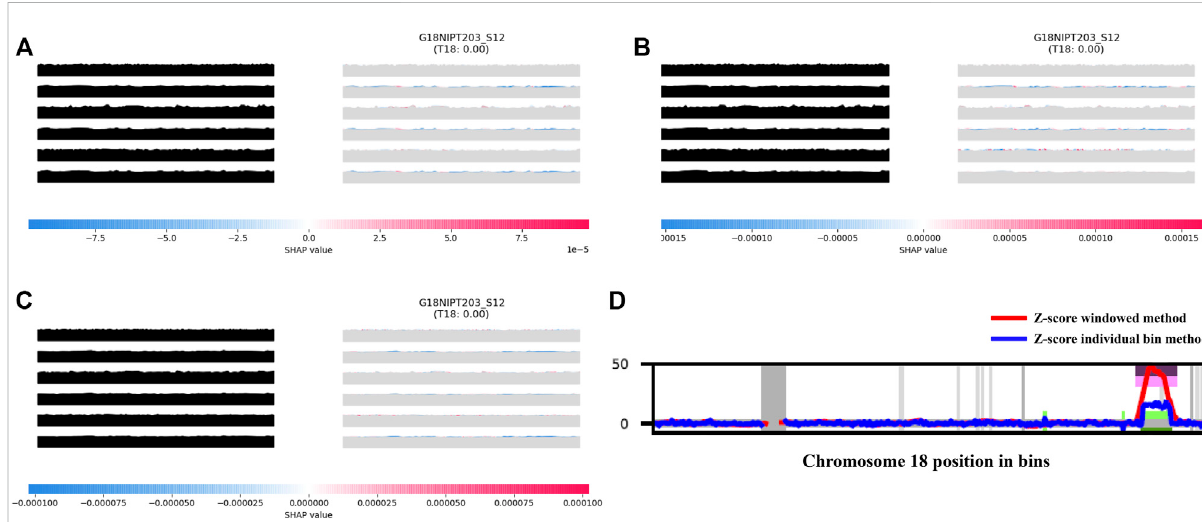
FIGURE 3 aiD-NIPTanalysis;aiD_IQR (A) ,aiD_Mean (B) ,andaiD_Median (C) ofthesamplewithtrisomy18false-positiveresultintheconventionalcount- based analysis, and theresult of thebinanalysis (D) . The featureimportanceof theTC atthe2nd, 4th, and 6thpositionson thetarget repeatstacking image displays a negative value on the distribution. Through the WIthin-SamplE COpy Number aberration DetectOR (WISECONDOR) analysis, the subchromosomal copy number variant on chromosome 18 was found. Such regions were removed in the aiD-NIPT training process. aiD: arti fi cial intelligence of fragment distance; IQR: interquartile range; NIPT: non-invasive prenatal testing; SHAP: Shapley additive explanations; TC: target